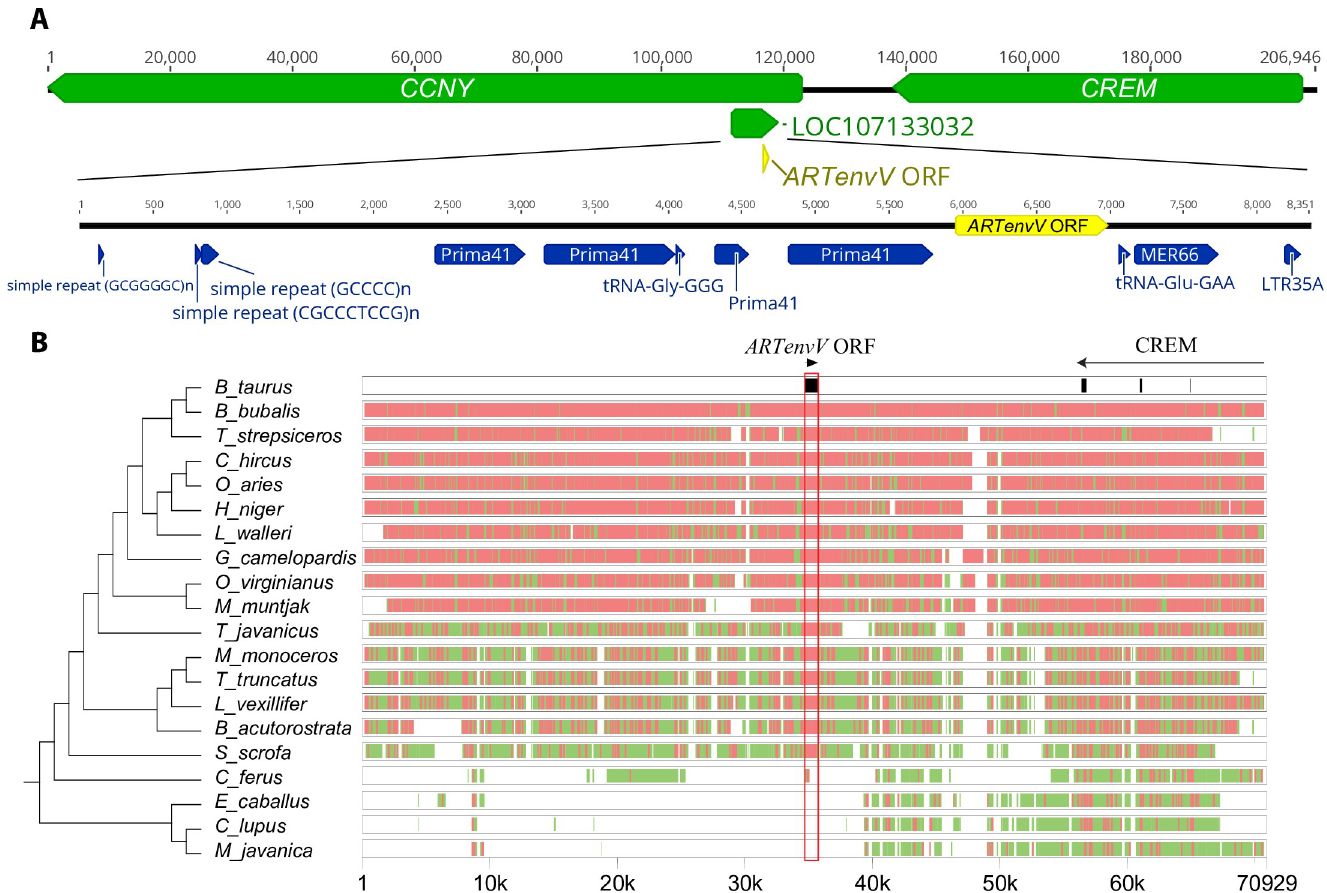
Fig 3. Genomic location and conserved synteny of ARTenvV . A. (Upper panel) The chromosomal context of the ARTenvV locus is shown for B . taurus (ARS-UCD1.2, chromosome 13). Refseq annotated genes are shown in green with the location of the ARTenvV ORF in yellow. (Lower panel) ERV derived repeat elements that are identified by the Dfam repeat database for the indicated region are annotated in blue. B. Genomic segments containing ARTenvV ORF and the CREM gene were extracted from the NCBI genome database for each of the indicated species and aligned using the MultiPipMaker alignment tool [108]. ARTenvV ORF and the exons of CREM are shown in black boxes in the B . taurus reference assembly. Regions with more than 75% identity are shown as red boxes while regions with 50–75% identity are shown as green boxes. On the left is a cladogram representing the phylogenetic relationships for the analyzed species generated using TimeTree [82].